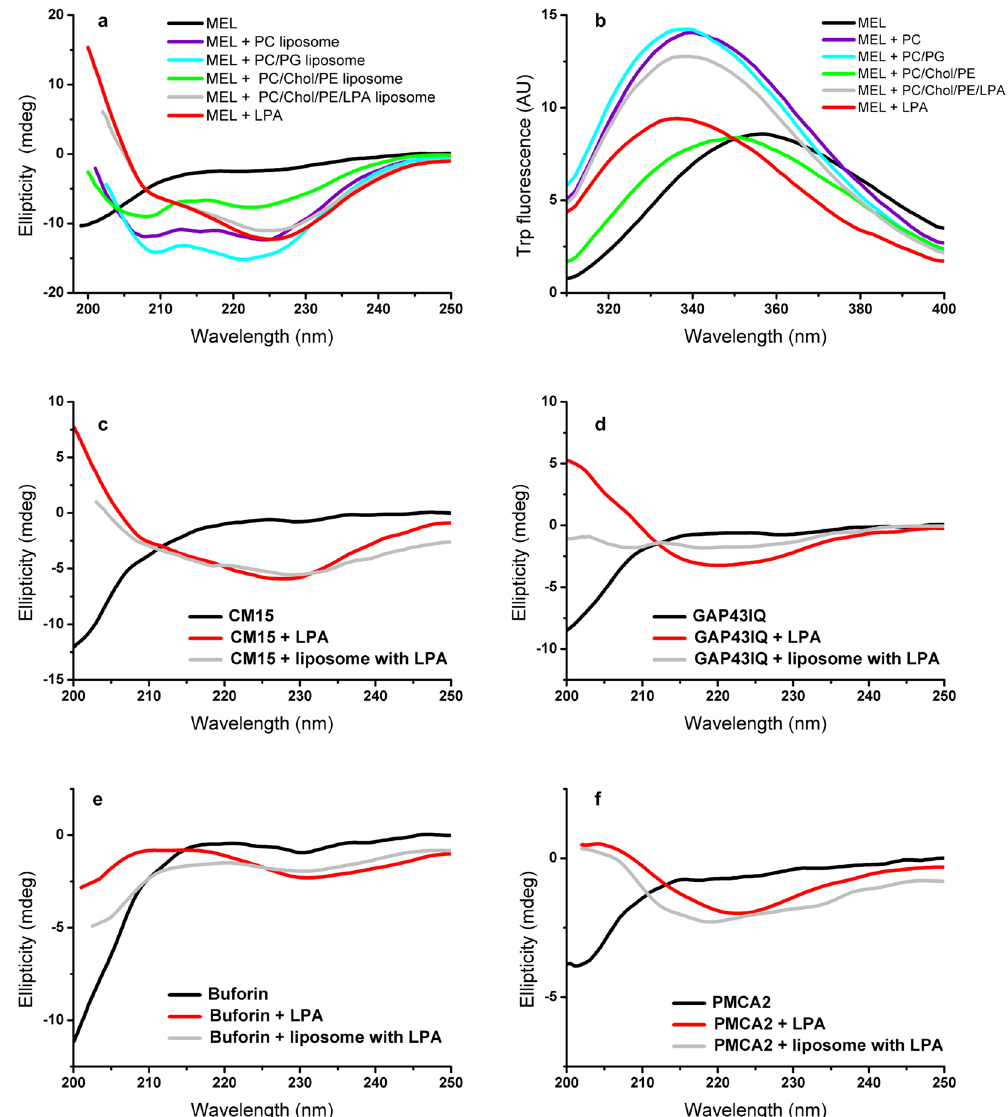
peptides CM15 (36 µ M), GAP43IQ (36 µ M), buforin (36 µ M), and PMCA2 (17 µ M) in the presence of LPA- containing liposomes. All spectra were recorded in high-salt buffer. Spectra taken with LPA micelles (100 μ M lipid) are also shown for comparison. For molar composition of the liposomes see Methods section. Nominal lipid concentrations for the liposomes were as follows: ( a) PC, and PC/PG 1.3 mM, PC/Chol/PE and PC/Chol/ PE/LPA 2 mM, ( b) 100 μ M for all liposomes. ( c – f ) PC/Chol/PE/LPA 1